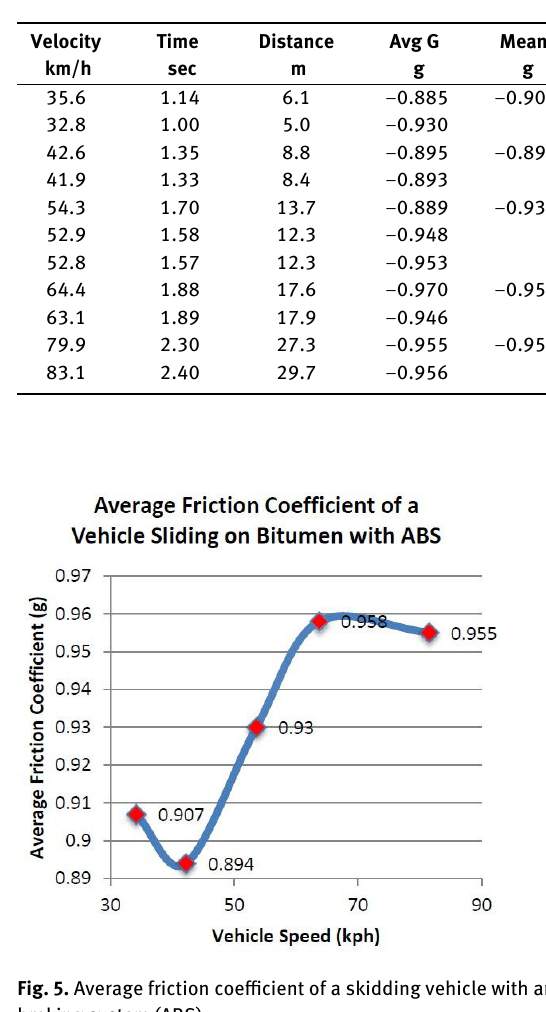
Table 1. Average friction coefficient of a vehicle sliding on bitumen with antilock braking system enabled (ABS on).